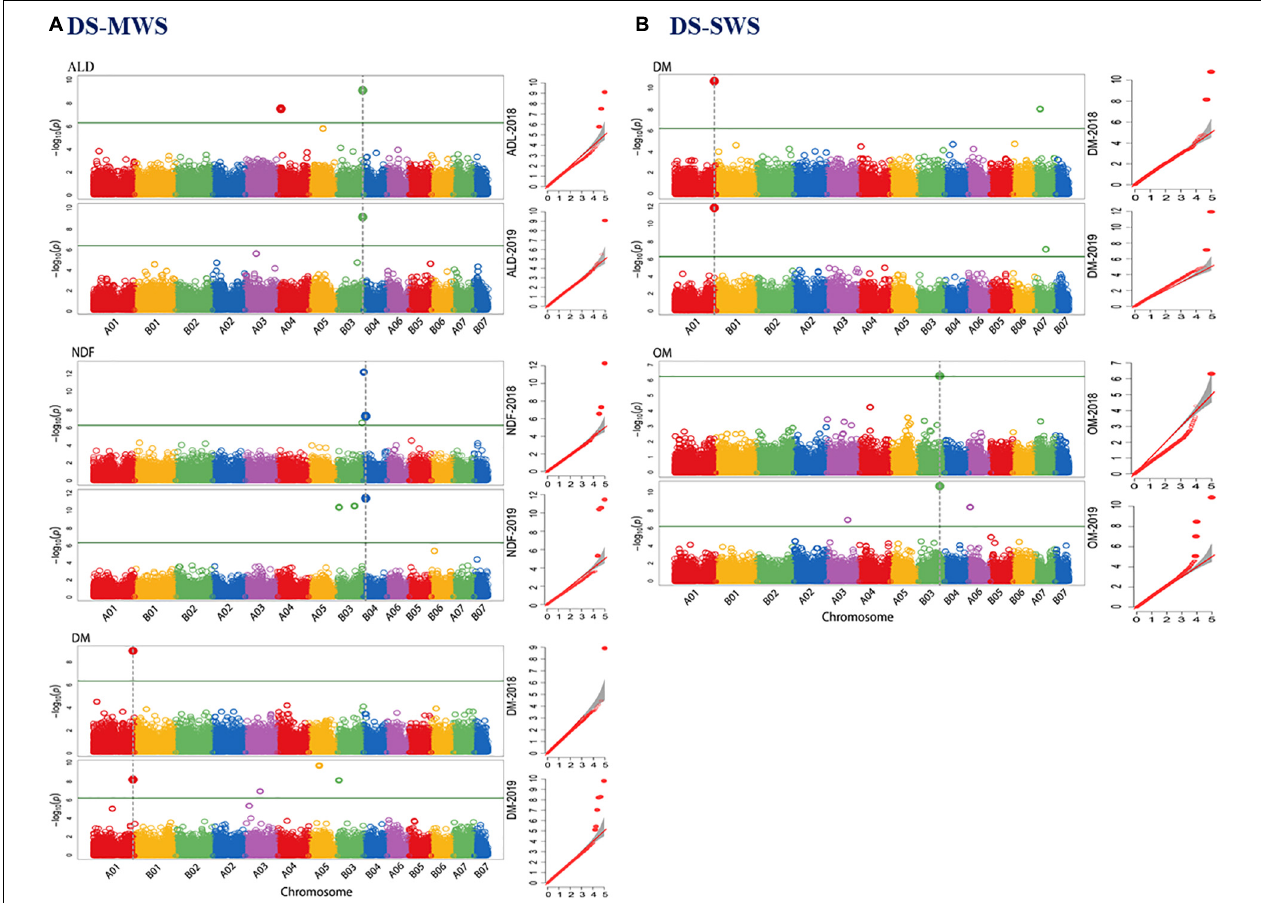
FIGURE 6 | Manhattan and quantile-quantile (Q-Q) plots of markers that showed overlapping associations for 2 years data of the nutritional quality traits in dry season under moderate water stress (DS-MWS) (A) , and dry season under severe water stress (DS-SWS) (B) conditions. Markers are on the x -axis per the 14-assembled chromosomes (AC). The –log10 of P values are plotted on the y -axis. The traits are shown at the left: acid detergent lignin (ADL), dry matter (DM), neutral detergent fiber (NDF), and organic matter